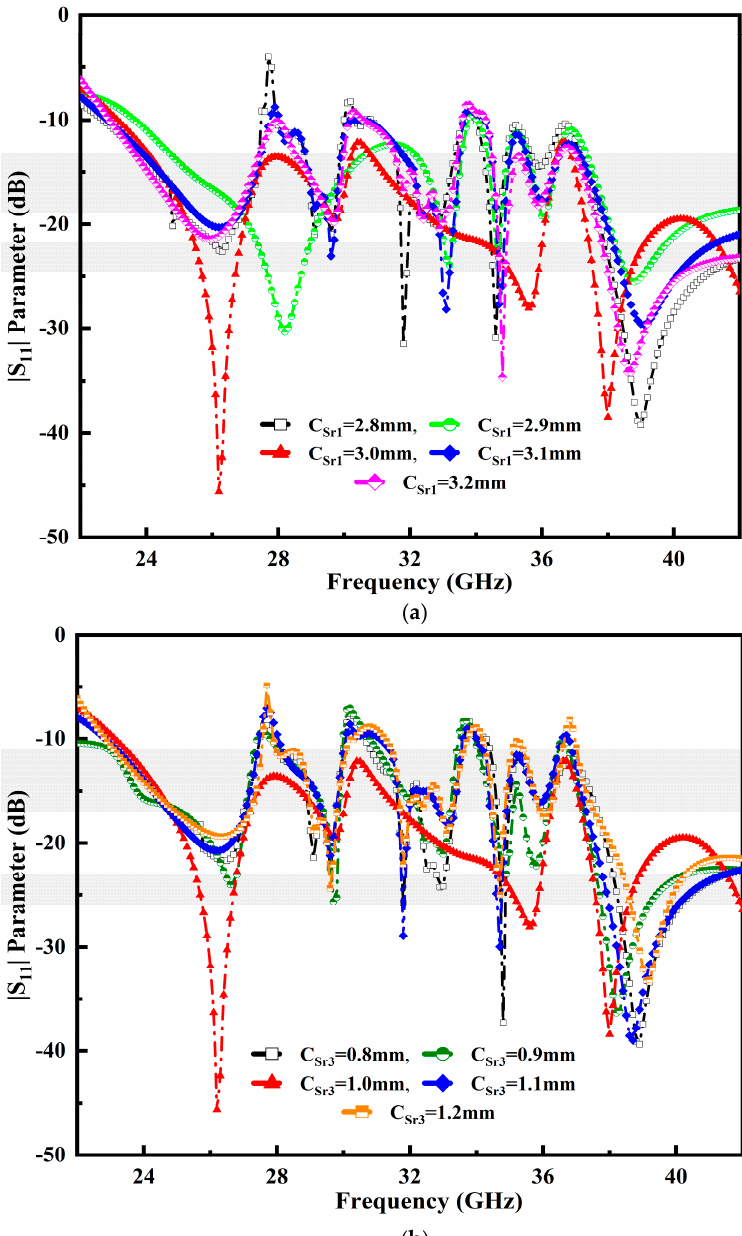
Figure 4. Influence of variable impacts: ( a ) a cavity radial stub 1 (C Sr1 ) and ( b ) cavity radial stub 3 (C Sr3 ) over the entire operable frequency range.